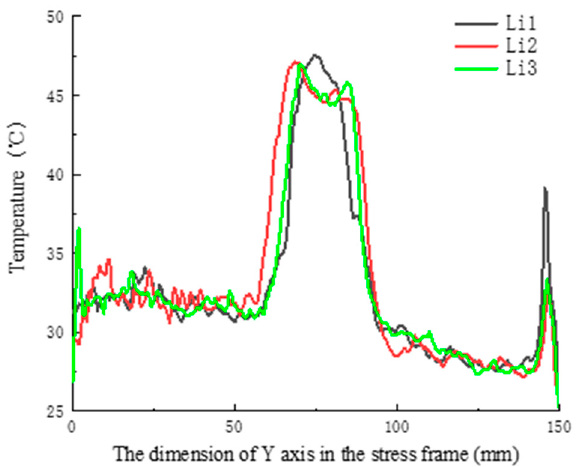
Figure 9. Temperature distribution graph of line 1, line 2, and line 3.